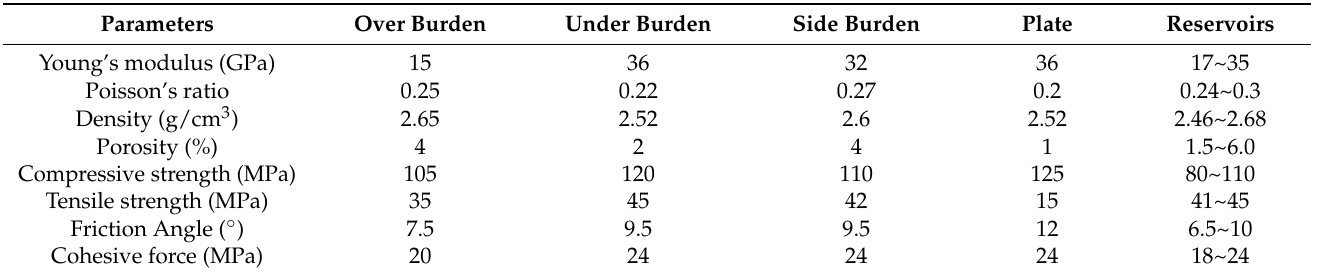
Figure 10. Geomechanical model grid diagram of the target formation. Table 3. The parameters of geomechanical model for the target formation.